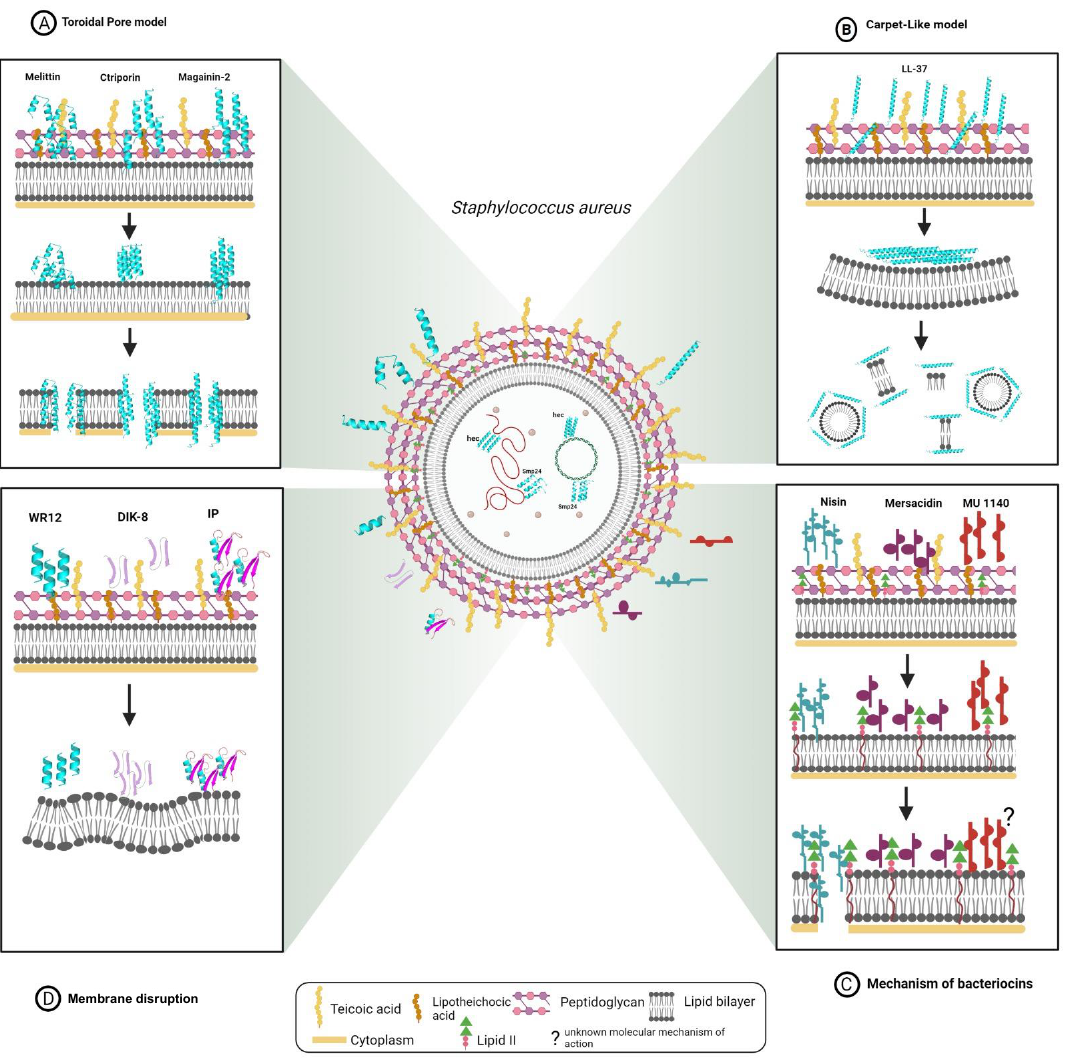
Figure 1. Mechanisms of action model of AMPs that showed antibacterial activity against VRSA and VISA strains. ( A ) AMPs that cause the formation of pores and cracks in the bacterial membrane; ( B ) AMPs that interact with the bacterial membrane causing its disruption through carpet model; ( C ) AMPs that cause a bactericidal effect through disruption and damage of the membrane; ( D ) Bacteria-derived AMPs that that interact with the bacterial membrane causing disruption and the formation of pores.